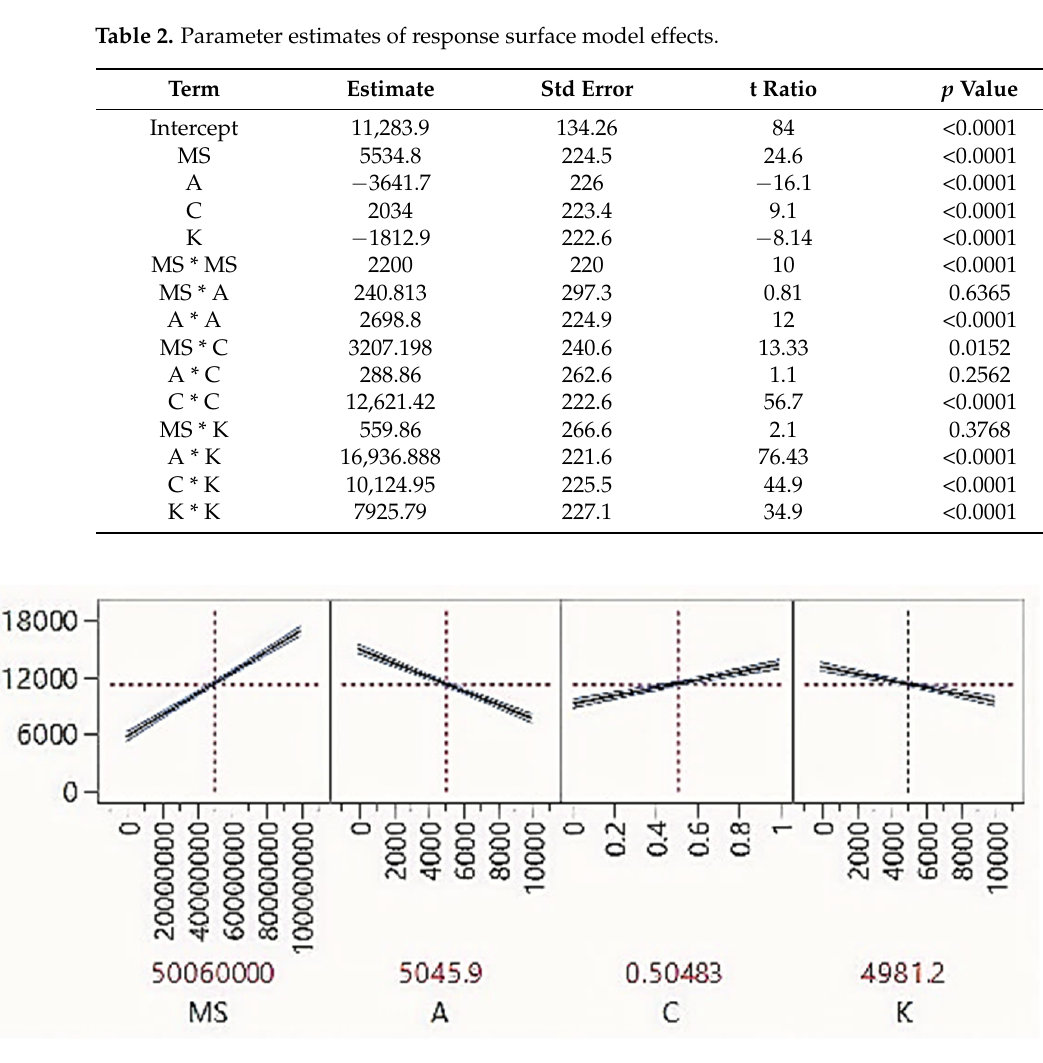
Figure 2. Prediction profiler for the linear